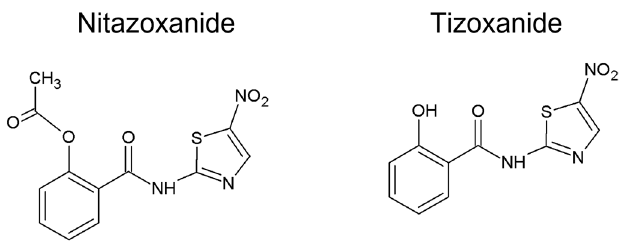
Figure 5. Structures of nitazoxanide and its metabolite tizoxanide.